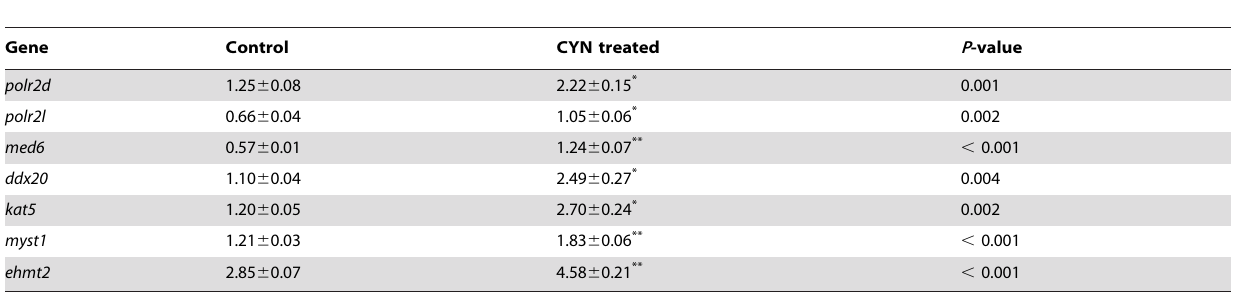
Table 1. Relative gene expression of polr2d , polr2l , med6 , ddx20 , kat5 , myst1 and ehmt2 in differentiated Caco-2 cells after 24 hrs exposure to 1.6 m M